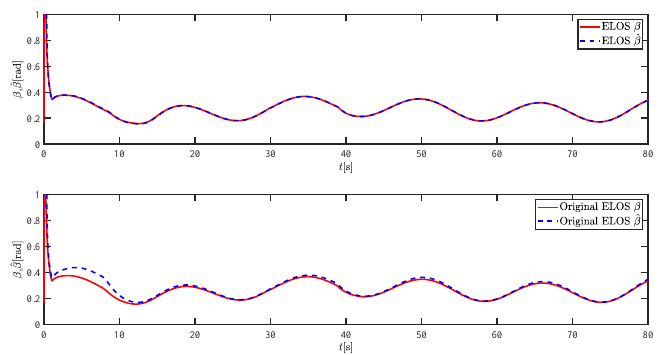
Figure 29. Along-track error x e and cross-track error y e under severe disturbance.